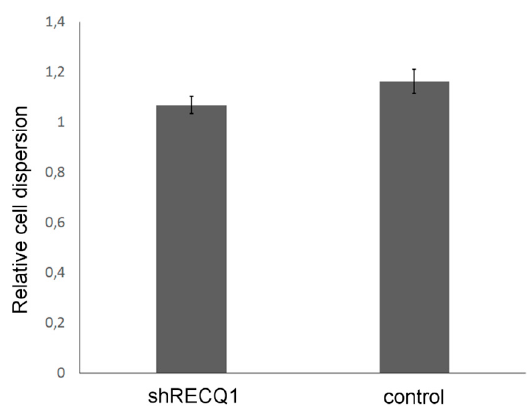
Figure 6. Relative invasion of RECQ1-silenced and control U87 cells between day 1 and day 3 after implantation. No significant differences in the rate of invasion were found. Means ± SE are shown.